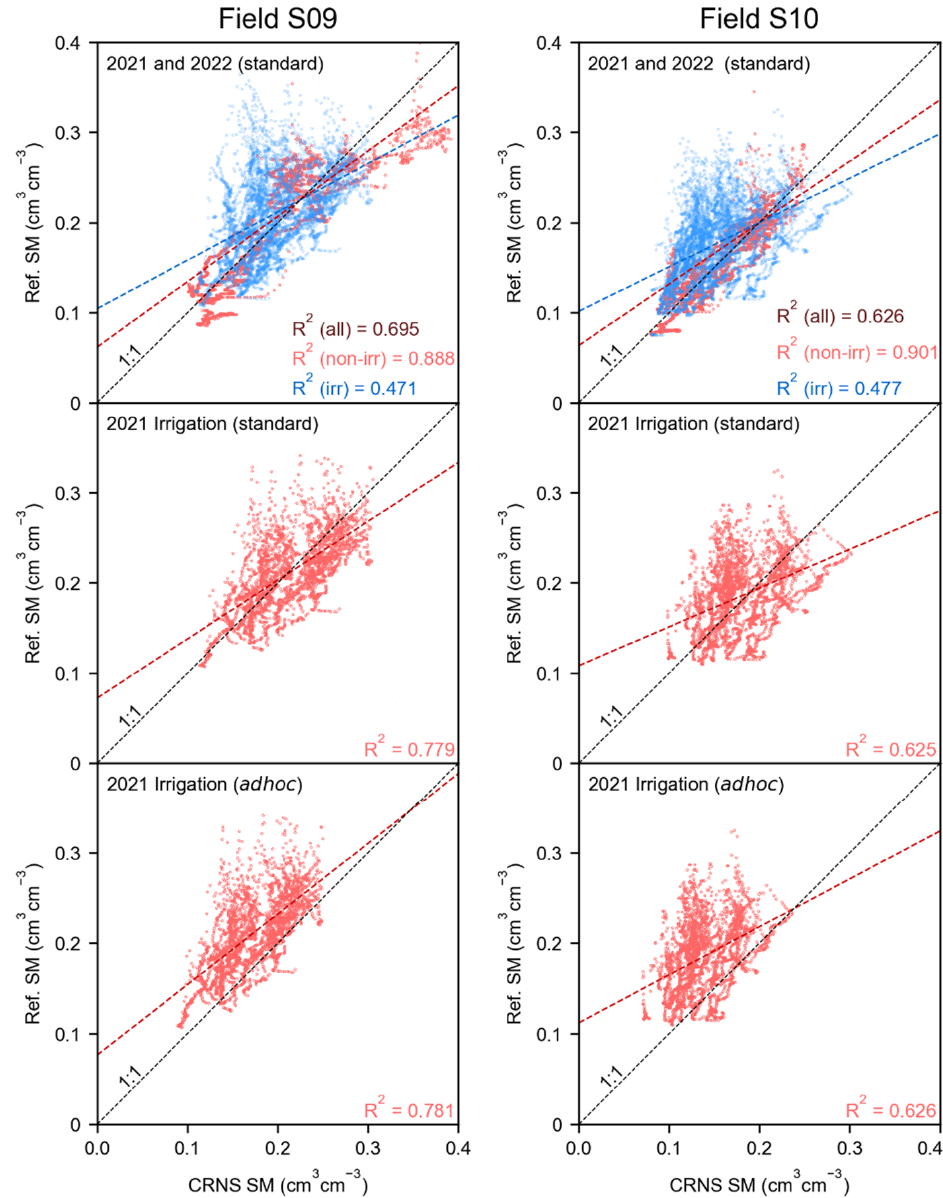
Figure A2. Regressions between the reference SM from SoilNet, and the CRNS-derived SM for fields S09 and S10. The upper panels show the entire measurement period with R 2 for all available measurements (all), non-irrigated (non-irr), and irrigated (irr) periods. Central panels show the use of a standard calibration for the 2021 irrigation, whereas bottom panels show the use of an ad hoc calibration for the same period.